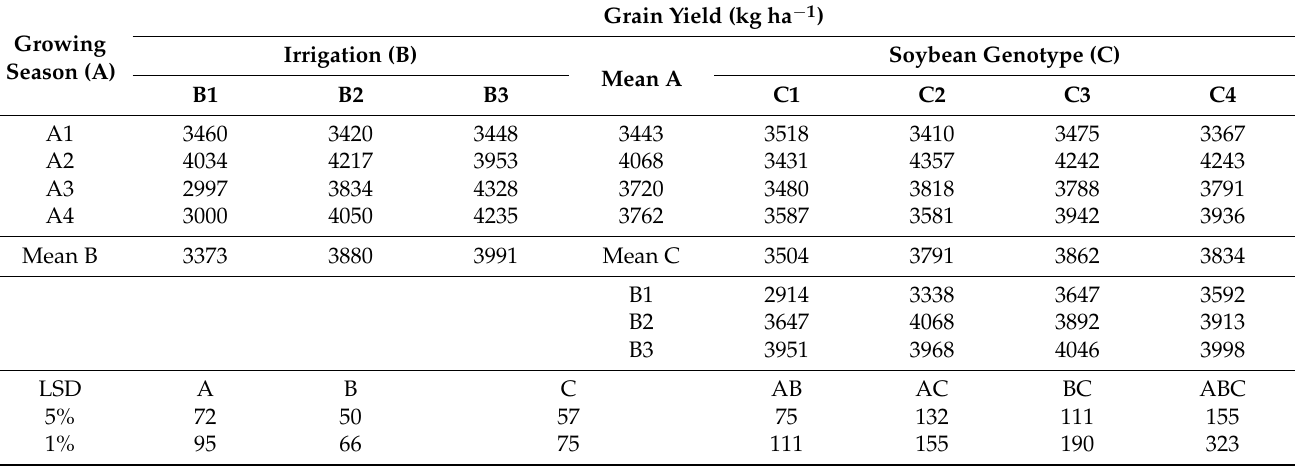
Table 2. Impacts of the environmental conditions in the four growing seasons (A1–A4), three treatments (B1, rain-fed conditions; B2, 60% of the field water capacity, or FWC; B3, 80–100% of the FWC), four genotypes (C1–C4) and their interactions (AB, AC, BC and ABC) on soybean grain yield (kg ha − 1